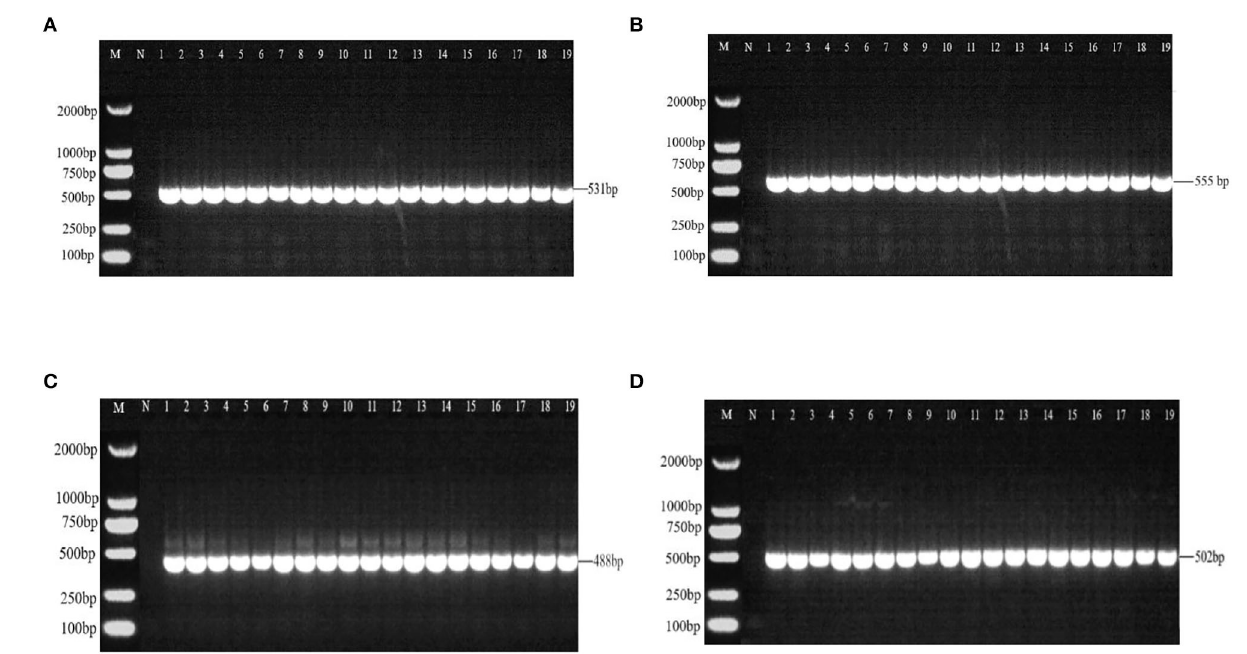
FIGURE 1 | PCR results of drug-resistant target genes gyrA (A) , gyr B (B) , parC (C) , and parE (D) . M: DL2000; N: Negative control; 1 ∼ 10: Tibet 1-10; 11 ∼ 13: CIP-inducible strains; 14 ∼ 16: ENR-inducible strains; 17 ∼ 19: NOR-inducible